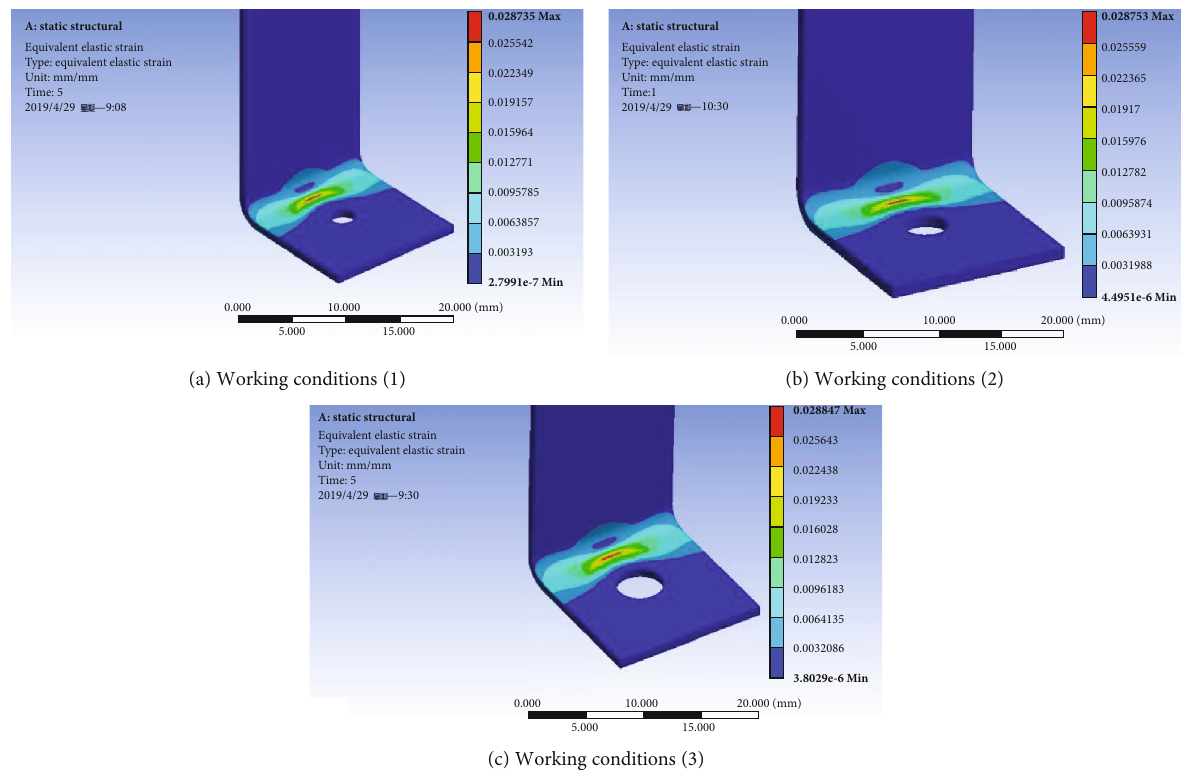
Figure 18: Strain cloud diagram corresponding to the change of the opening diameter of nylon ribbon.